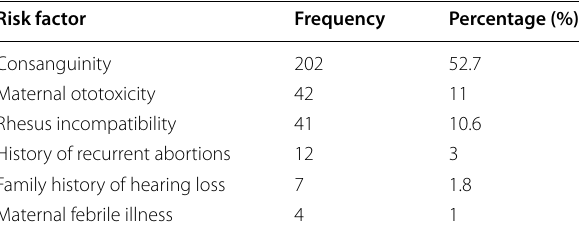
Table 2 Distribution of risk factors of hearing loss observed in well-baby nursery group (384 neonates) in order of frequency